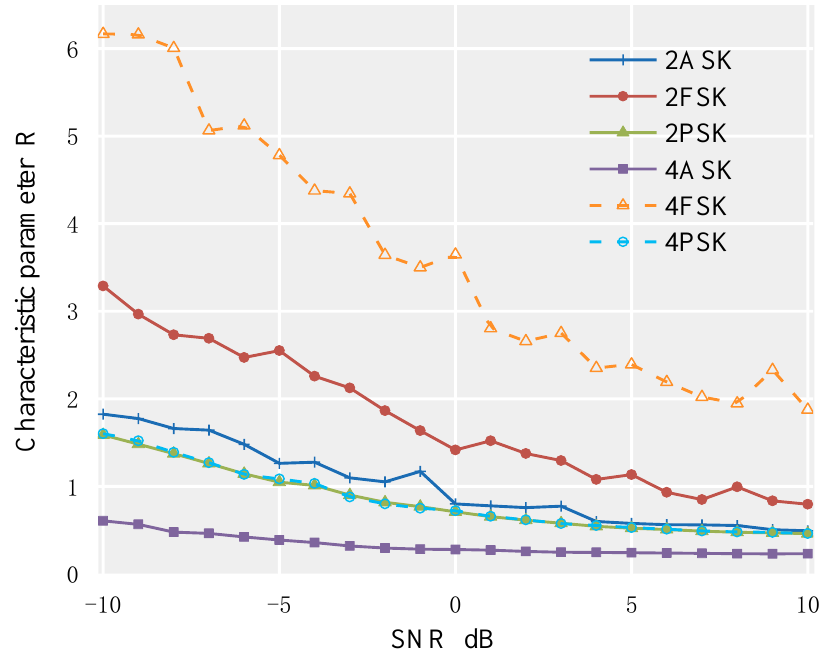
Figure 5. Cyclic characteristic parameter R of each modulated signal.